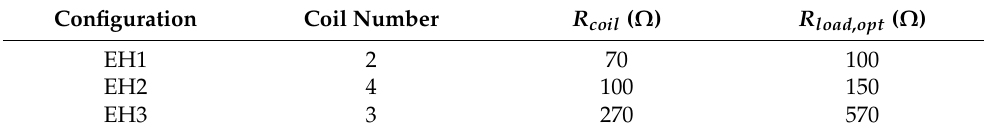
Table 6. Electric quantities used for tests.